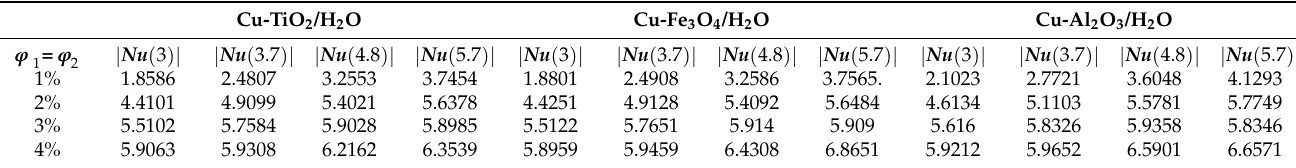
Table 4. The effect of different hybridized nanoparticles on Nusselt number ( Nu ) .